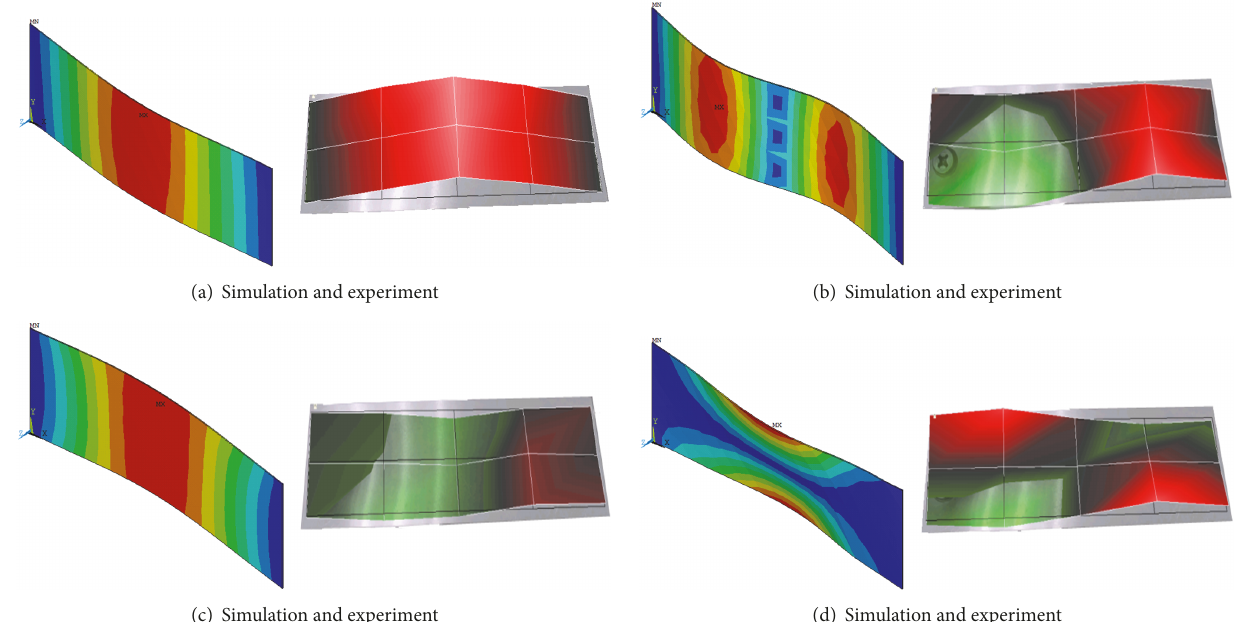
Figure 8: Contrast graphs of simulation and experiment values of the vibration mode of the first four orders. (a) The first-order vibration